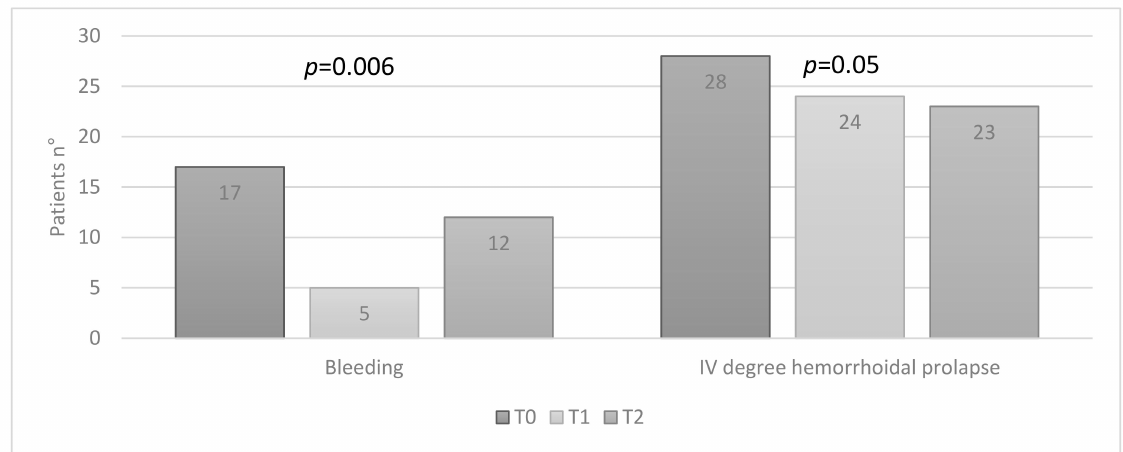
Figure 1. Group A: patients with bleeding and IV-degree hemorrhoidal prolapse at baseline visit (T0), first follow-up visit after 4 weeks of therapy (T1) and second follow-up visit 8 weeks after therapy discontinuation (T2) (Friedman